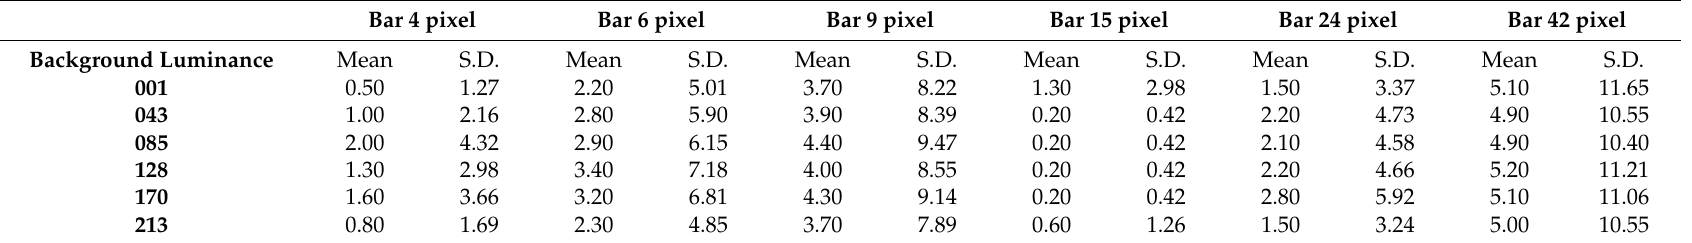
Table 4. Results of the first group of tests: uniform Bar on uniform Background, Background Luminance